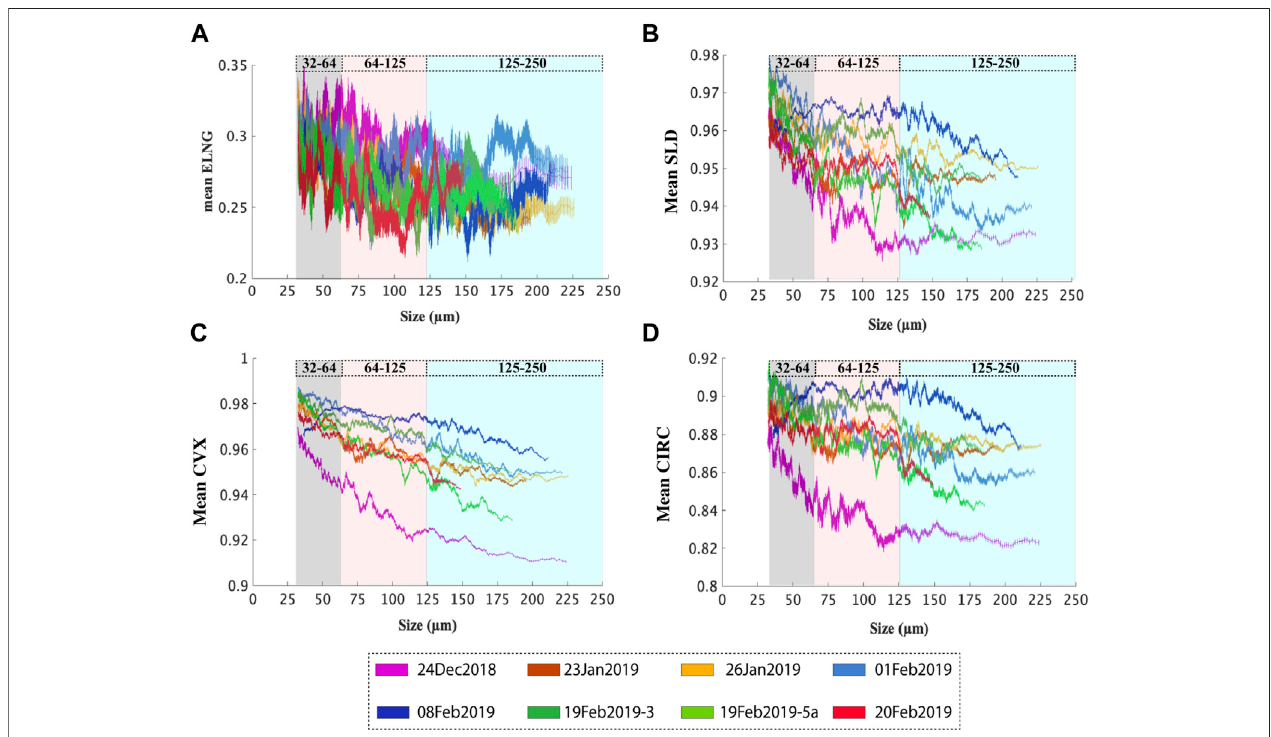
FIGURE 3 | Trend variation of the simple moving average (window size = 150 elements, horizontal shift = 1 element each moving step) of four shape parameters plotted against the particle size: (A) Elongation (ELNG); (B) Solidity (SLD); (C) Convexity (CVX); (D) Circularity (CIRC). The standard deviation of the values is also shown for each moving average step. The color-shaded area reported in the plots indicates the spatial boundaries between the class size intervals considered in Figure 4 .